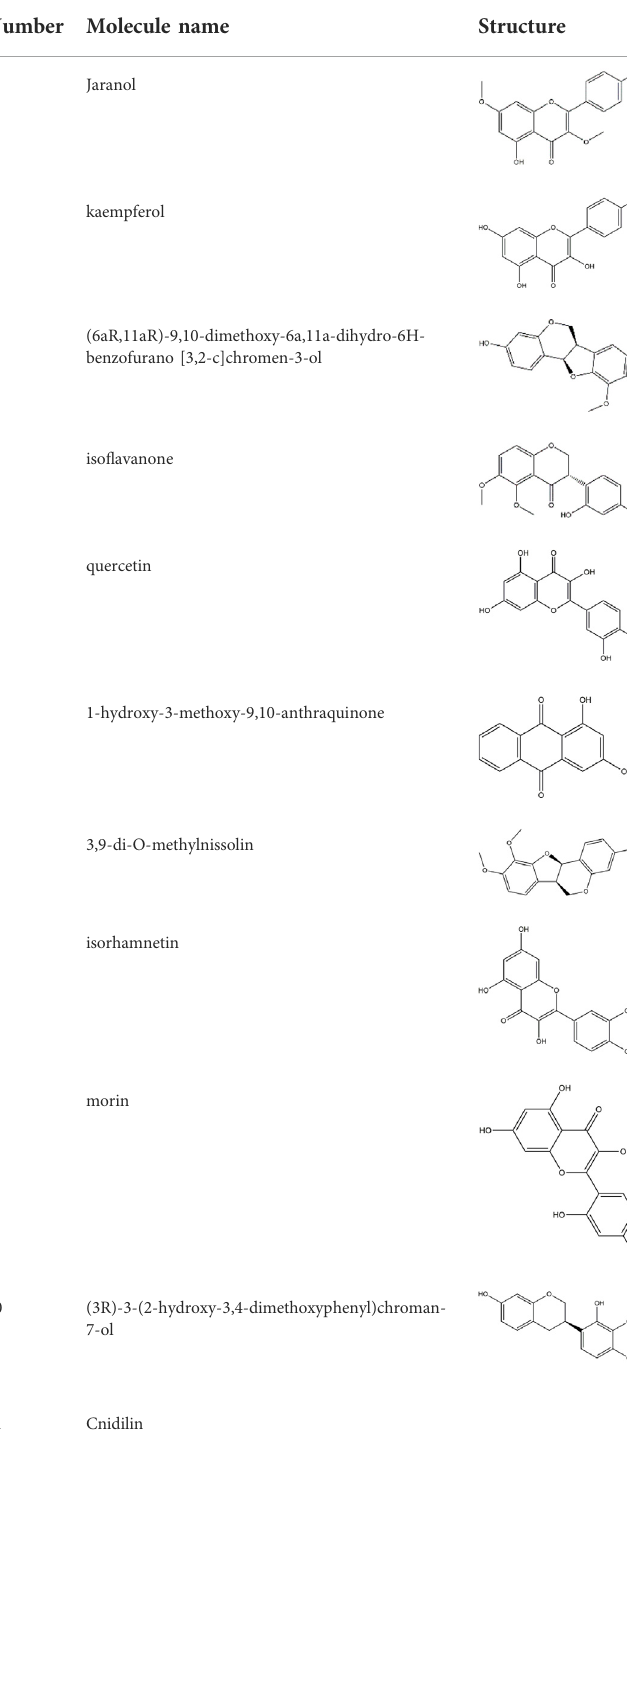
TABLE 4 The top 15 components with high degree value acted on the CCMM-MI common